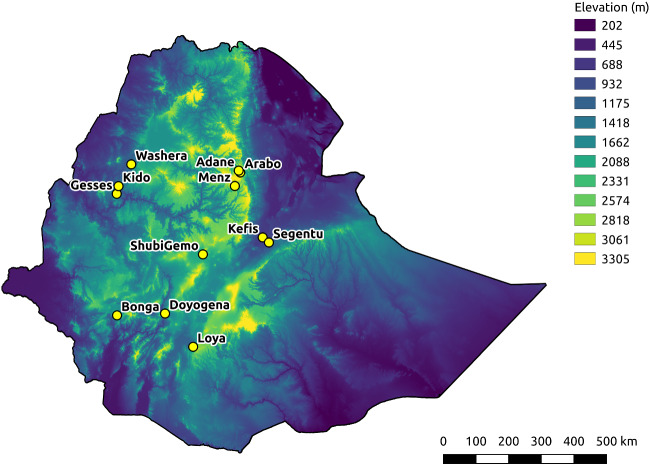
Altitude-coded map of Ethiopia with 12 sampling locations indicated.